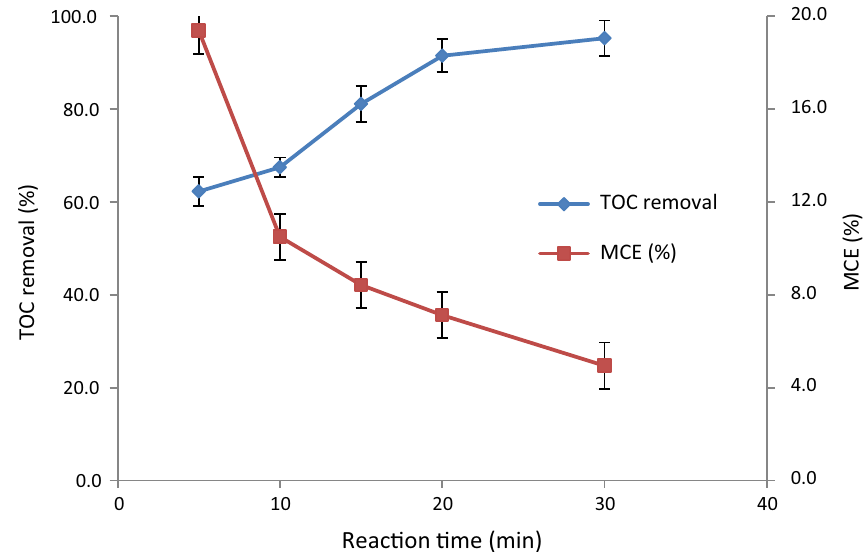
Fig. 9 TOC removal and min- eralization current efficiency (MCE) of MG by EFP (initial MG concentration = 200 mg/L; solution pH = inherent (3); cur- rent density = 10 mA/cm 2 ; H 2 O 2 dosage = 50